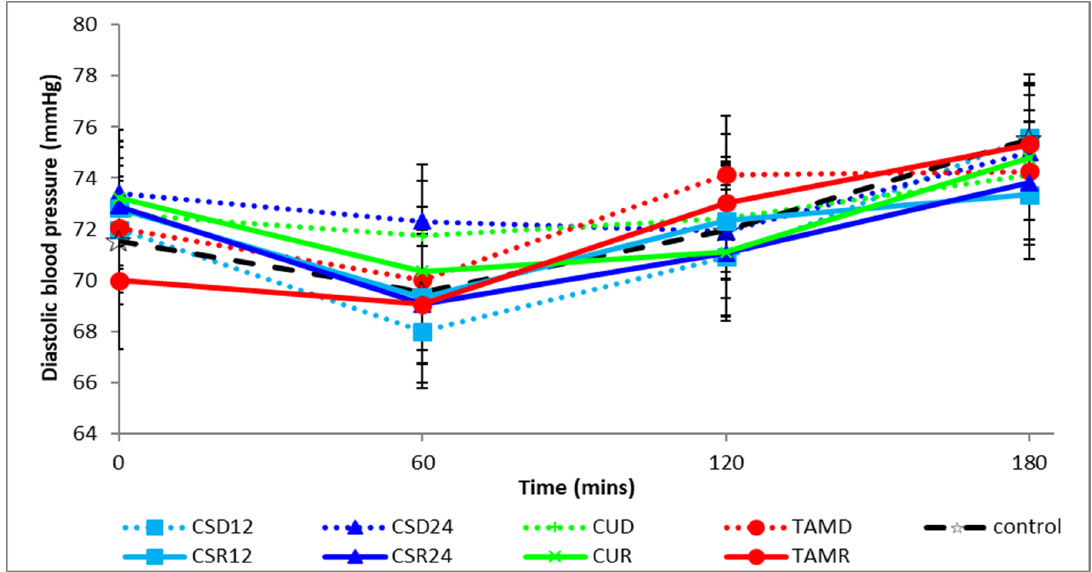
Figure 5. Postprandial changes in diastolic blood pressure during various treatments. CSD12: corn silk drink 12 g; CSR12: corn silk rice 12 g; CSD24: corn silk drink 24 g; CSR24: corn silk rice 24 g; CUD: cumin drink; CUR: cumin rice; TAMD: tamarind drink; TAMR: tamarind rice.